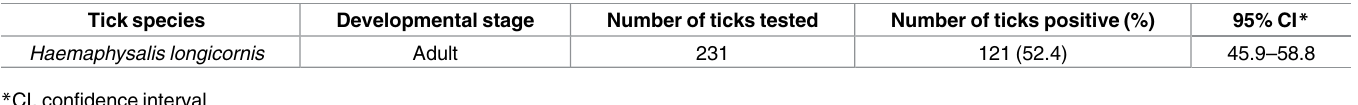
Table 1. Prevalence of Coxiella -like endosymbionts in ticks infesting horses reared on Jeju Island, Korea, determined by 16S rRNA nested PCR. Tick